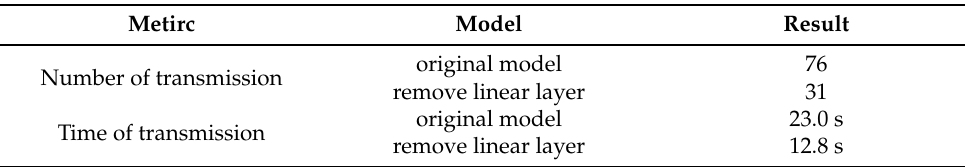
Table 9. Comparison of execution time on different model.